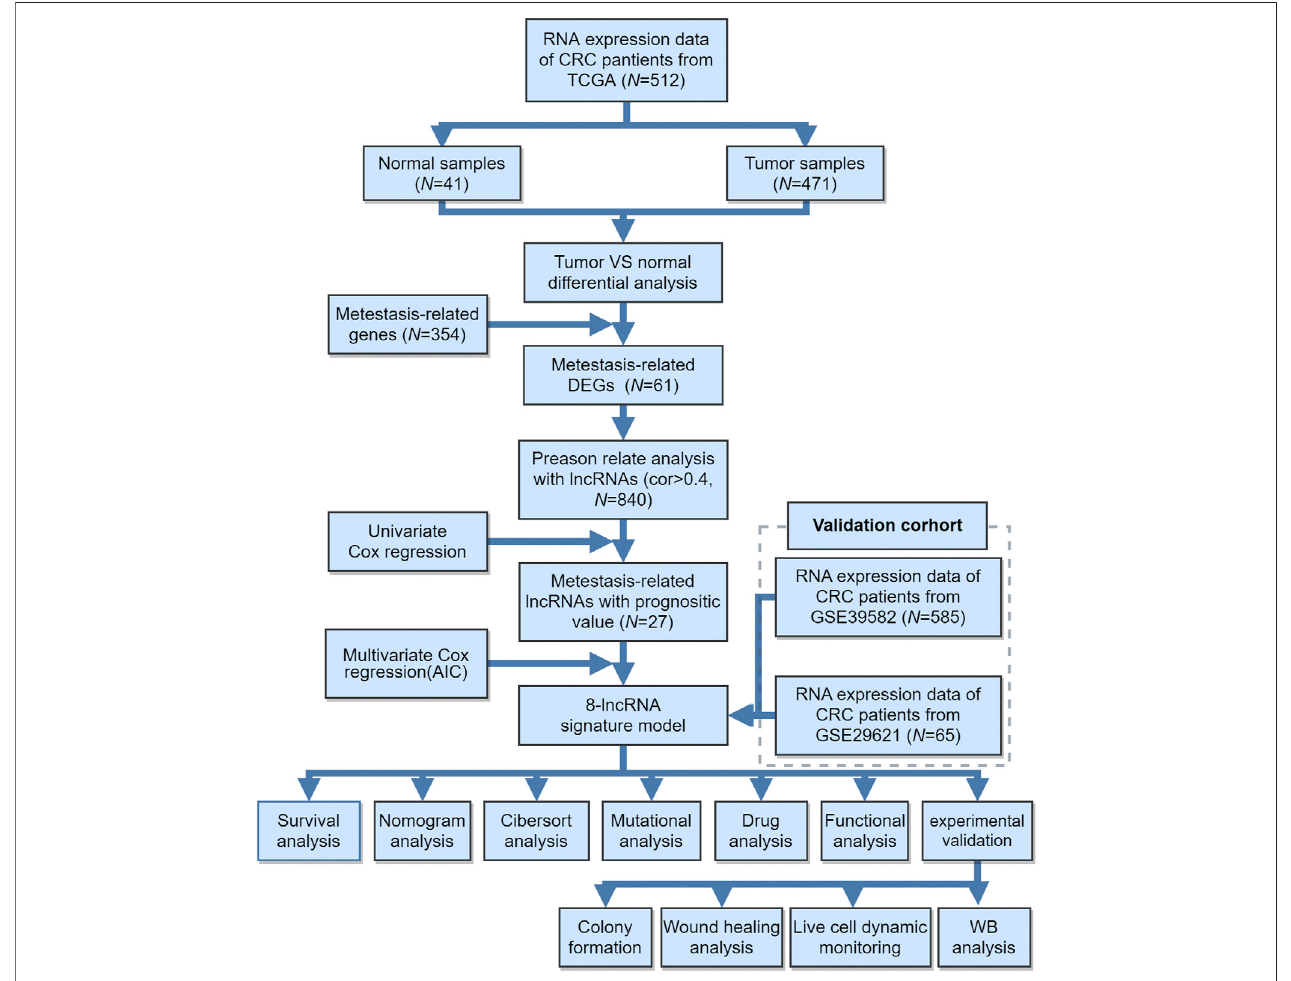
FIGURE 1 | Overview of the study design and analysis of metastasis-related